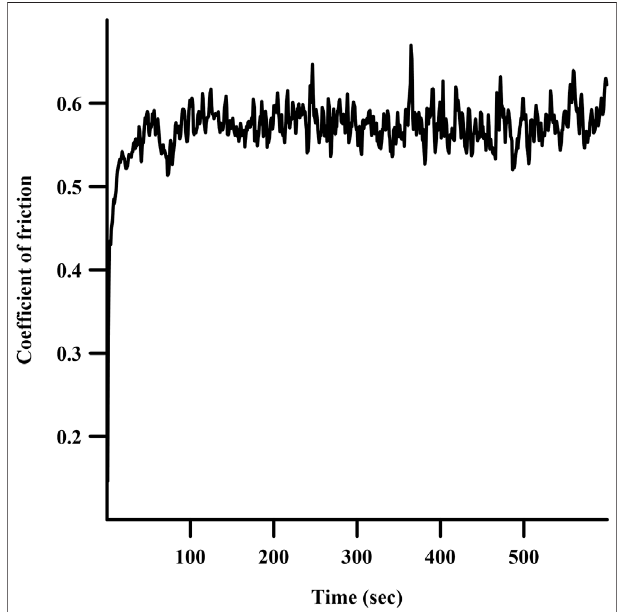
FIGURE11| Experimental resultsofCOFwithrespecttotimeat optimal